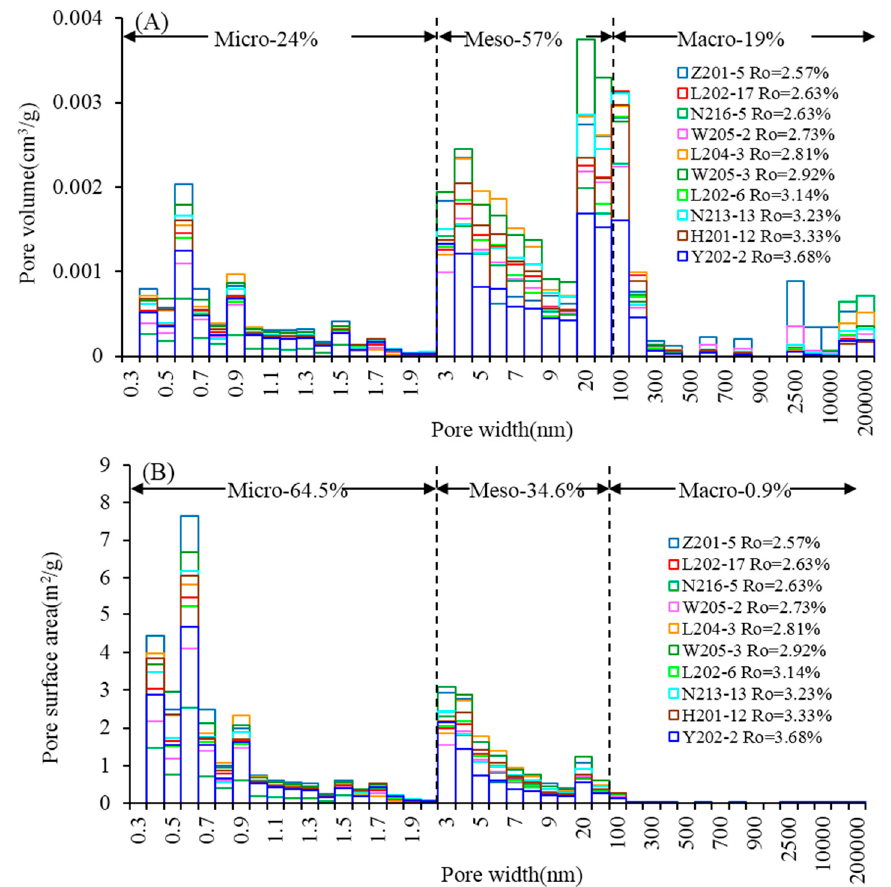
Figure 14. The PV ( A ) and SSA ( B ) distribution of different pore size scales according to the data from HMIP, N 2 and CO 2 adsorption experiments.